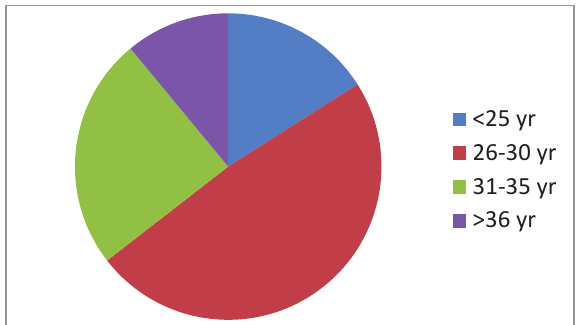
mean of 3.2±1.8 and median of